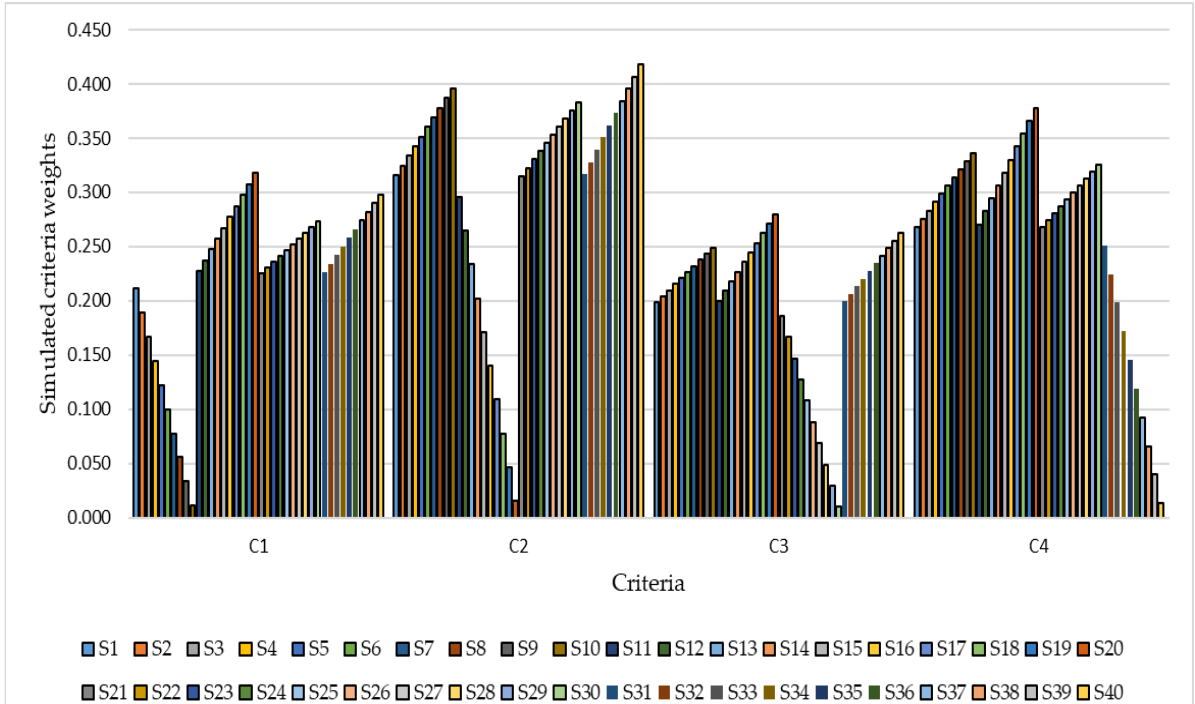
Figure 6. Simulated criterion values across 40 scenarios.